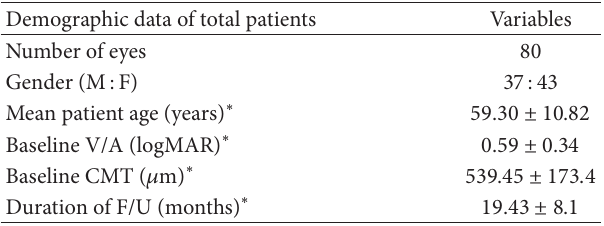
Table 2: Baseline characteristics of total subjects. Demographic data of total